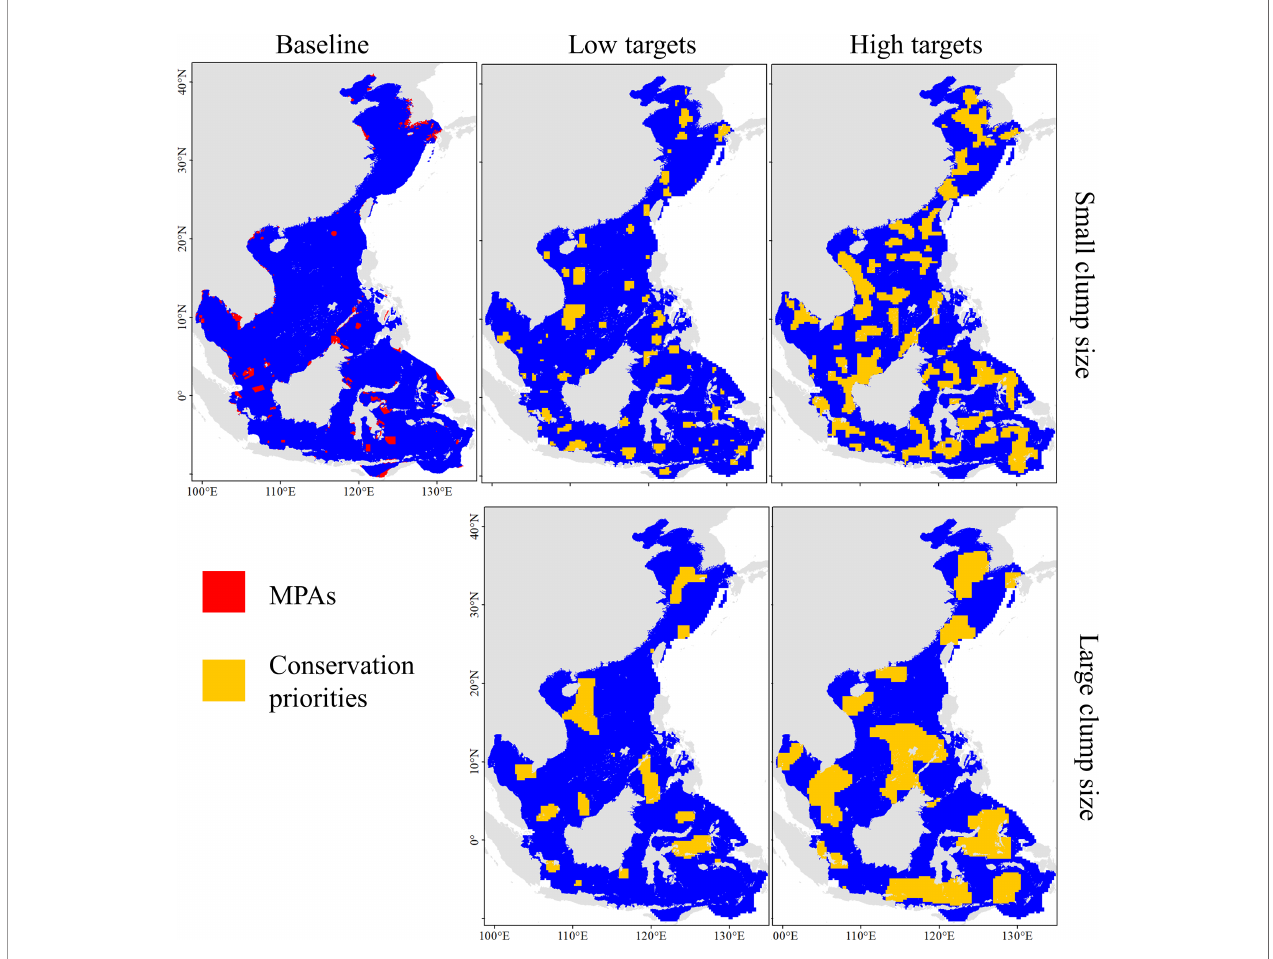
FIGURE 7 | Best solutions for conservation priorities under different